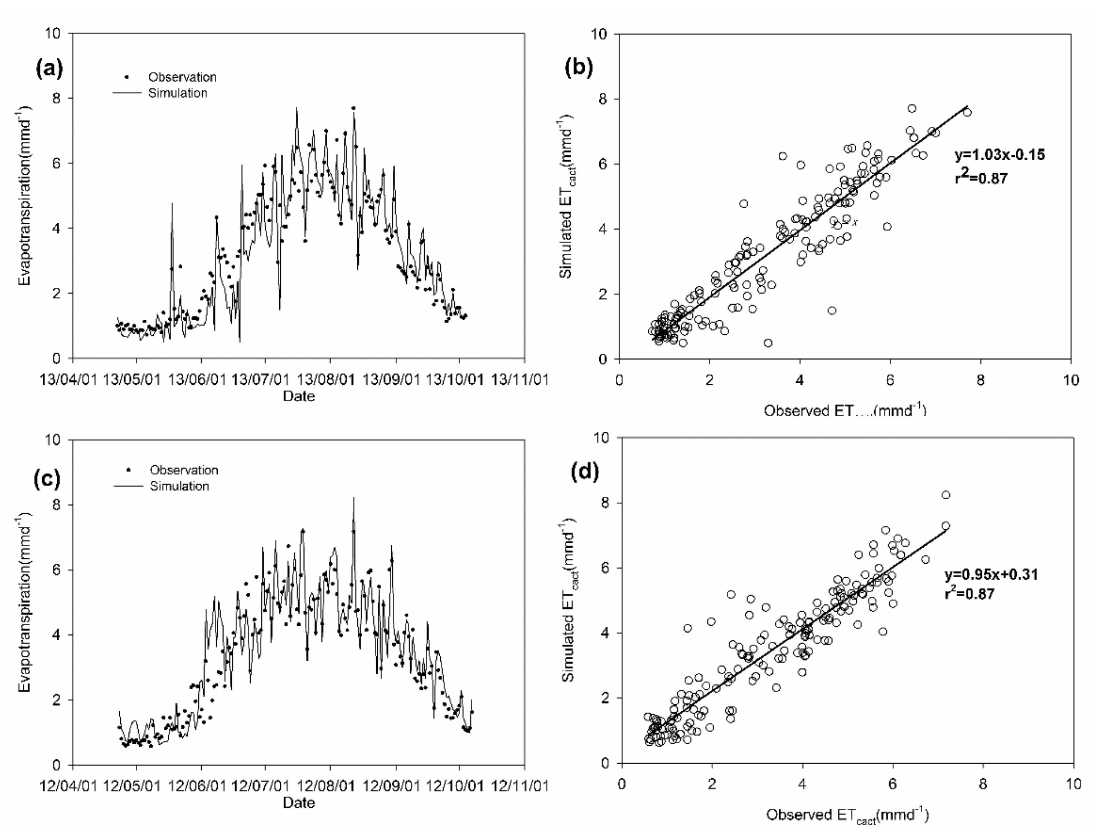
Figure 4. The comparison between observed (EC) and simulated ET c act : ( a , b ) the results of 2012 (calibration); and ( c , d ) the results of 2013